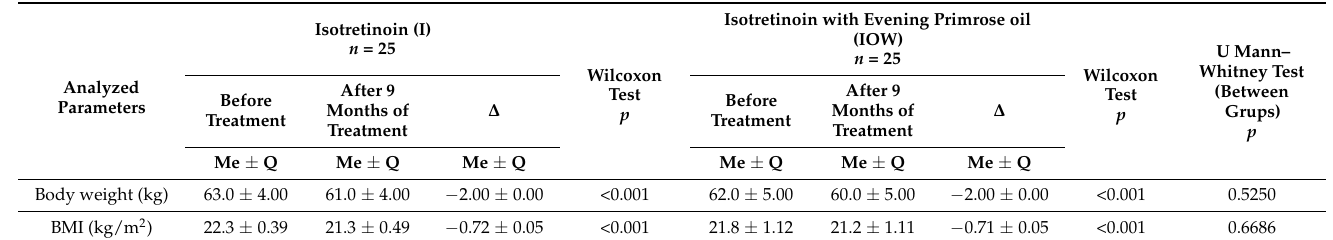
Table 4. Changes in body weight and BMI in groups using isotretinoin or isotretinoin with evening primrose oil.